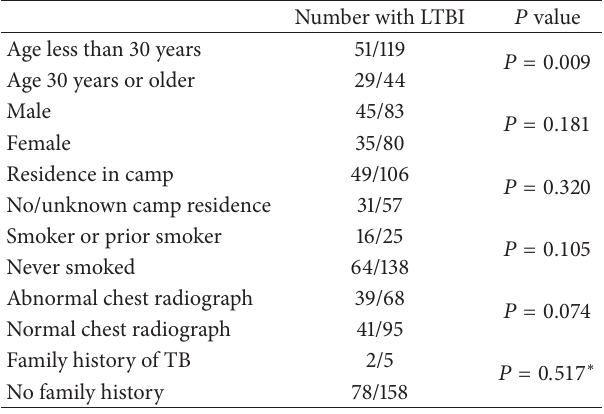
Table 2: Associations between demographic characteristics and diagnosis of